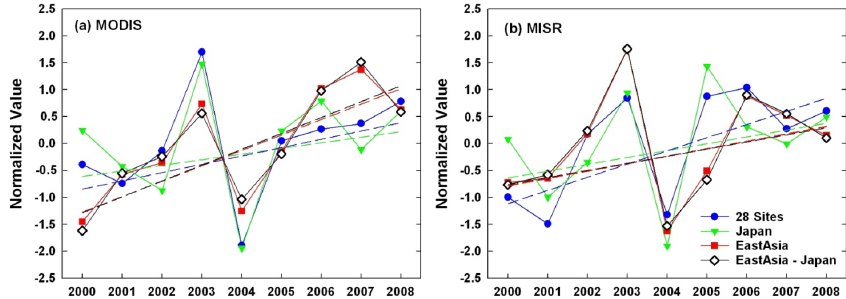
Fig. 15. Evolutions of MODIS AOD and MISR AOD averaged over 28 SSR sites, Japan, East Asia, and Japan-excluded East Asia. Dashed lines represent the linear tendencies excluding the year 2003 data.